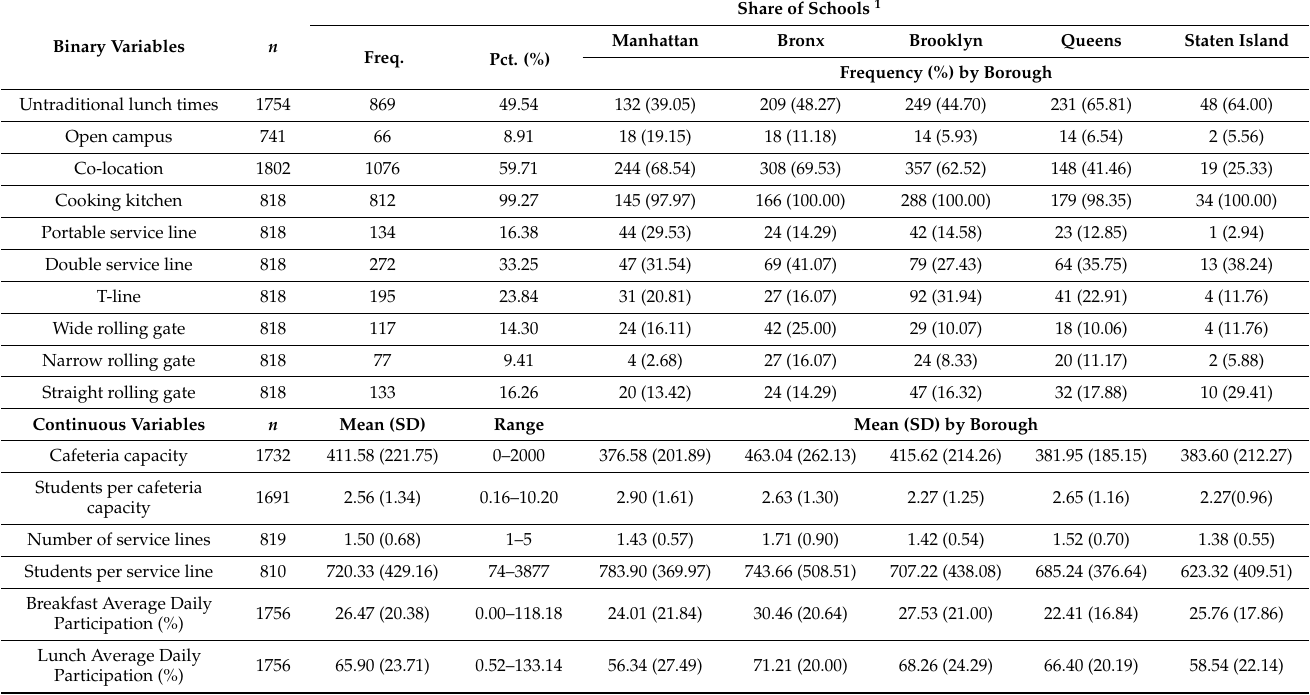
Table 1. Descriptive Statistics of School Infrastructure and Meal Program Characteristics among New York City Public